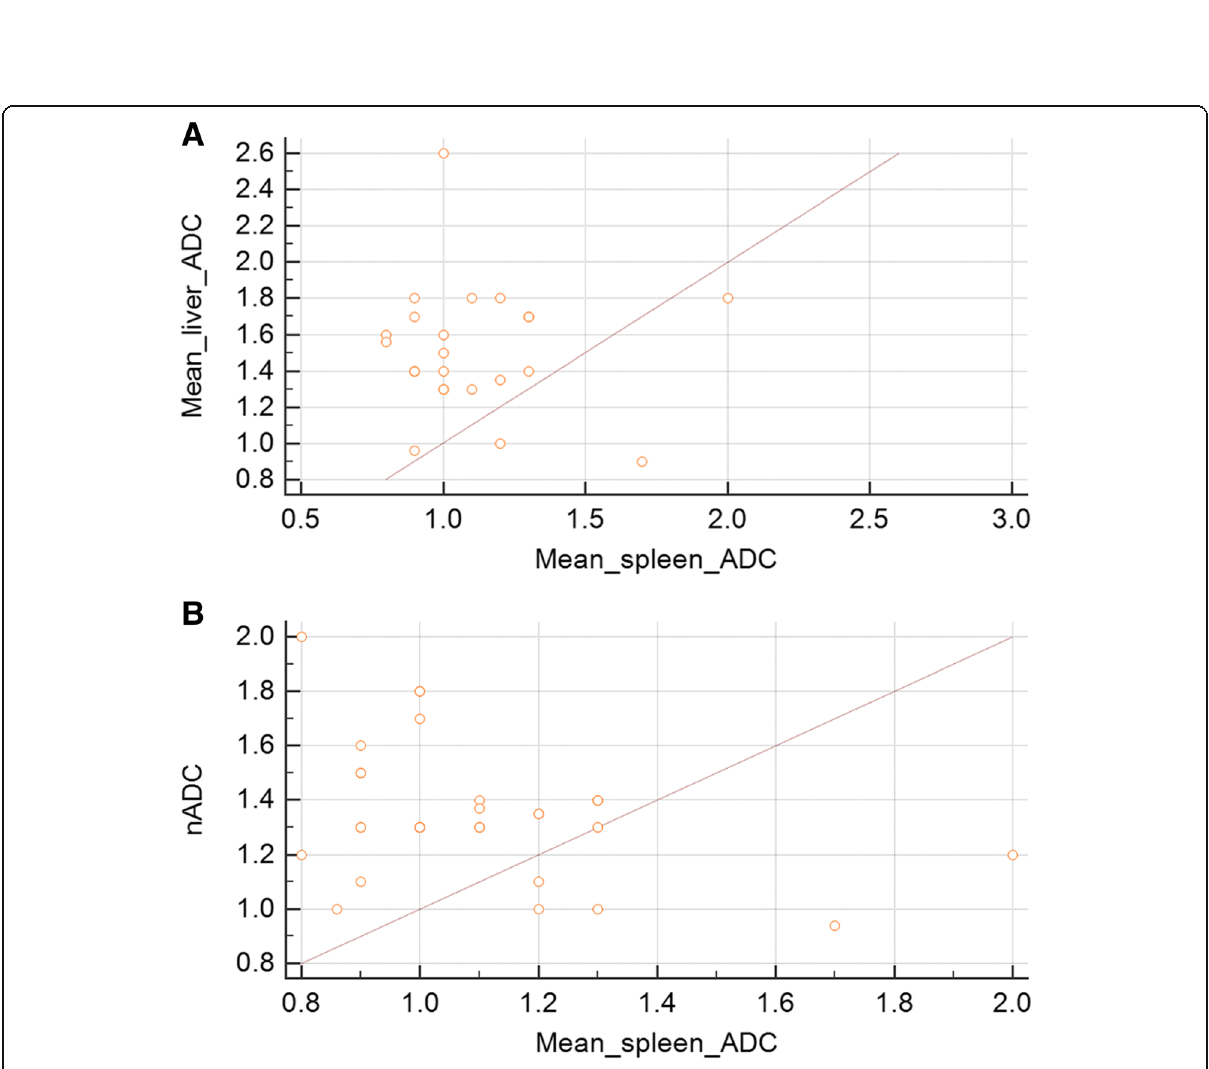
Fig. 3 a , b shows no significant correlation between liver and mean spleen ADC ( n = 30) of patients with different stages of fibrosis (Spearman's rank correlation coefficient rs = 0.00335; 95% CI: − 0.357 – 0.363, p = 0.9), also no significant correlation between nADC and mean spleen ADC(Spearman's rank correlation coefficient rs = - 0.225; 95% CI: − 0.538 – 0.125, p = 0.1743). (Image quality